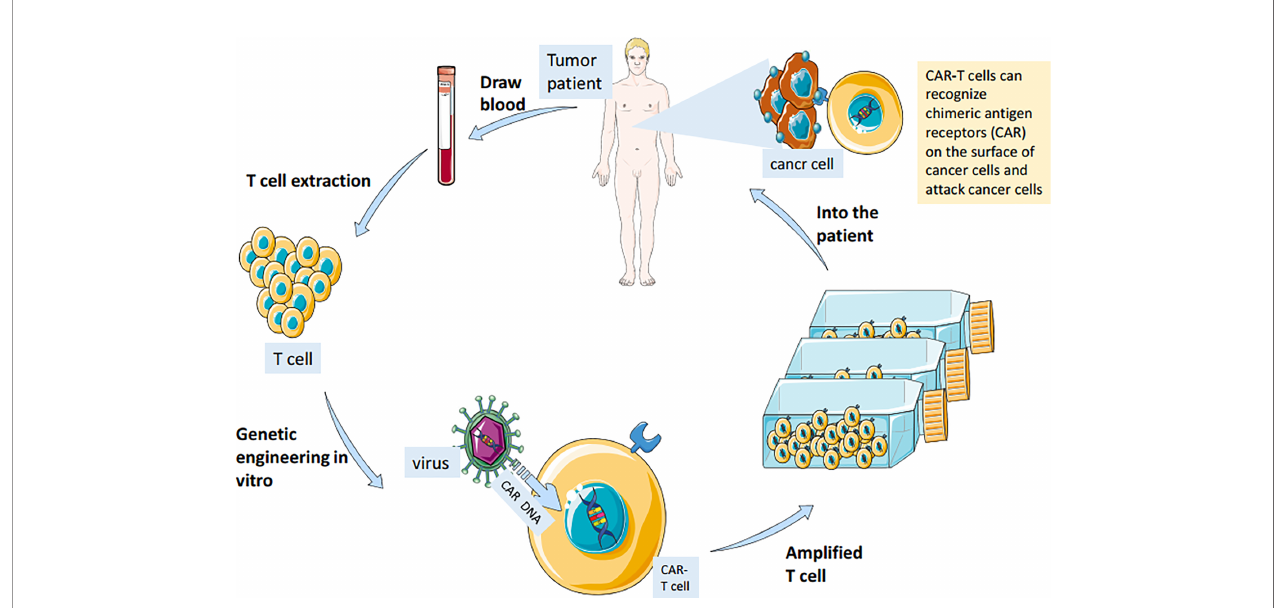
FIGURE 2 | Immune T cells were isolated from patients and genetically engineered in vitro to be fi tted with chimeric antigen receptors (CAR) that recognize cancer cell surface antigens. The modi fi ed cells are ampli fi ed in large Numbers in vitro and injected back into the patient to achieve the therapeutic effect of accurately identifying and killing cancer